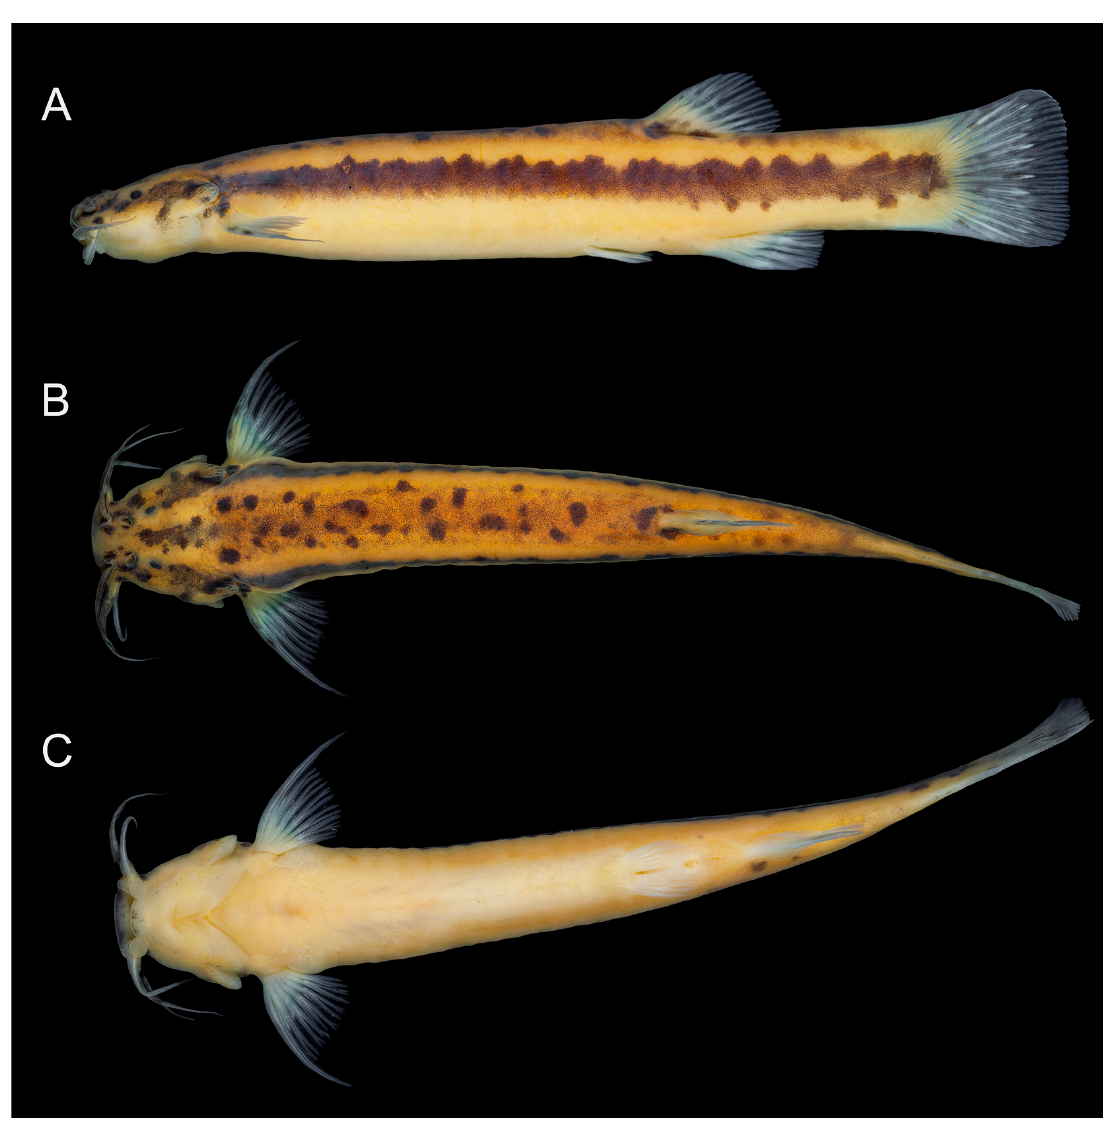
Figure 13. Trichomycterus ( Paracambeva ) adautoleitei Costa, Azevedo-Santos & Katz sp. nov. Holotype, UFRJ 13406, Carmo do Rio Claro, 57.1 mm SL: ( A ) lateral, ( B ) dorsal, and ( C ) ventral views.